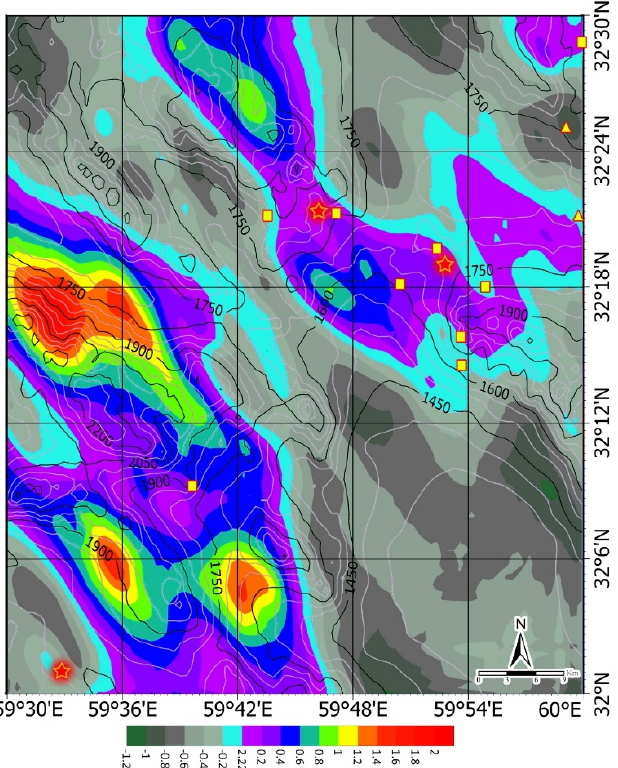
Figure 10. Geochemical map of high potential areas based on geochemical family of copper (Pb, Zn, Sn, Ag and Mo).